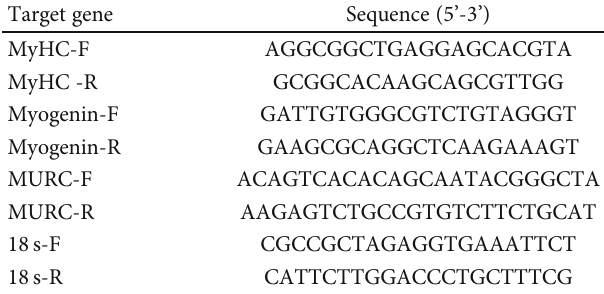
Table 1: Primers sequences used in the